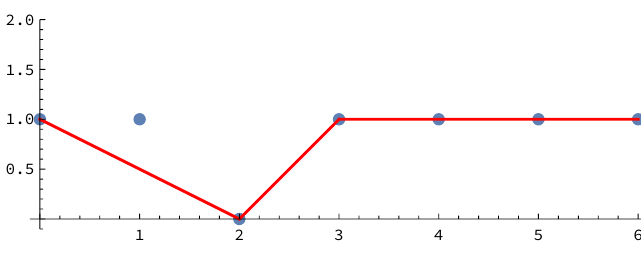
Figure 4 . The Newton polygon for the sound